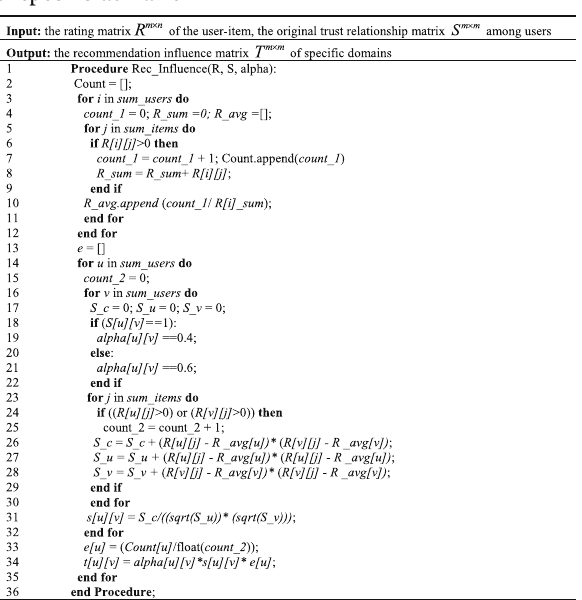
Algorithm 1. Generate a recommendation matrix T m × m of specific domains